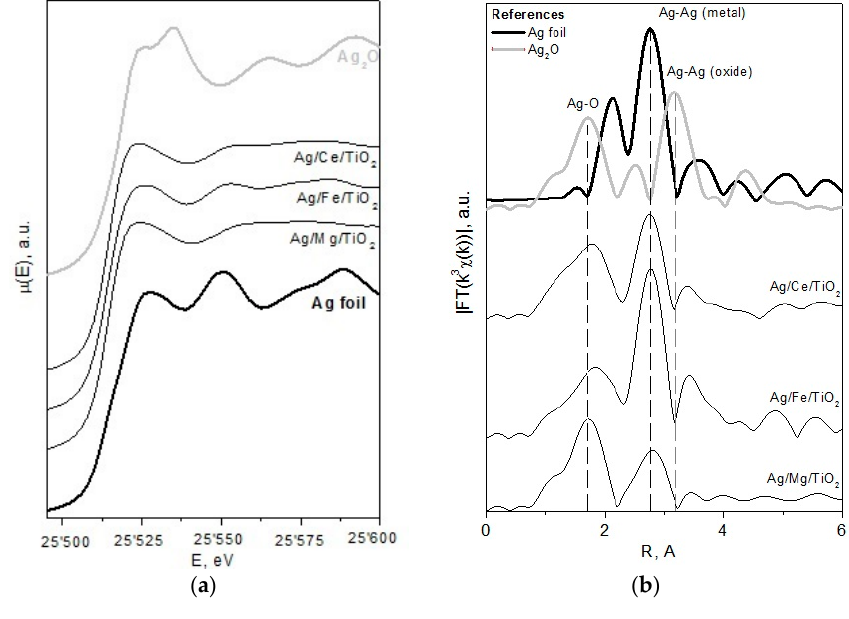
Figure 9. XANES ( a ) and EXAFS ( b ) spectra of catalysts treated in H 2 flow at 300 °C for 1 h. Table 3. Sample composition and structural parameters obtained from XAFS spectroscopies data.